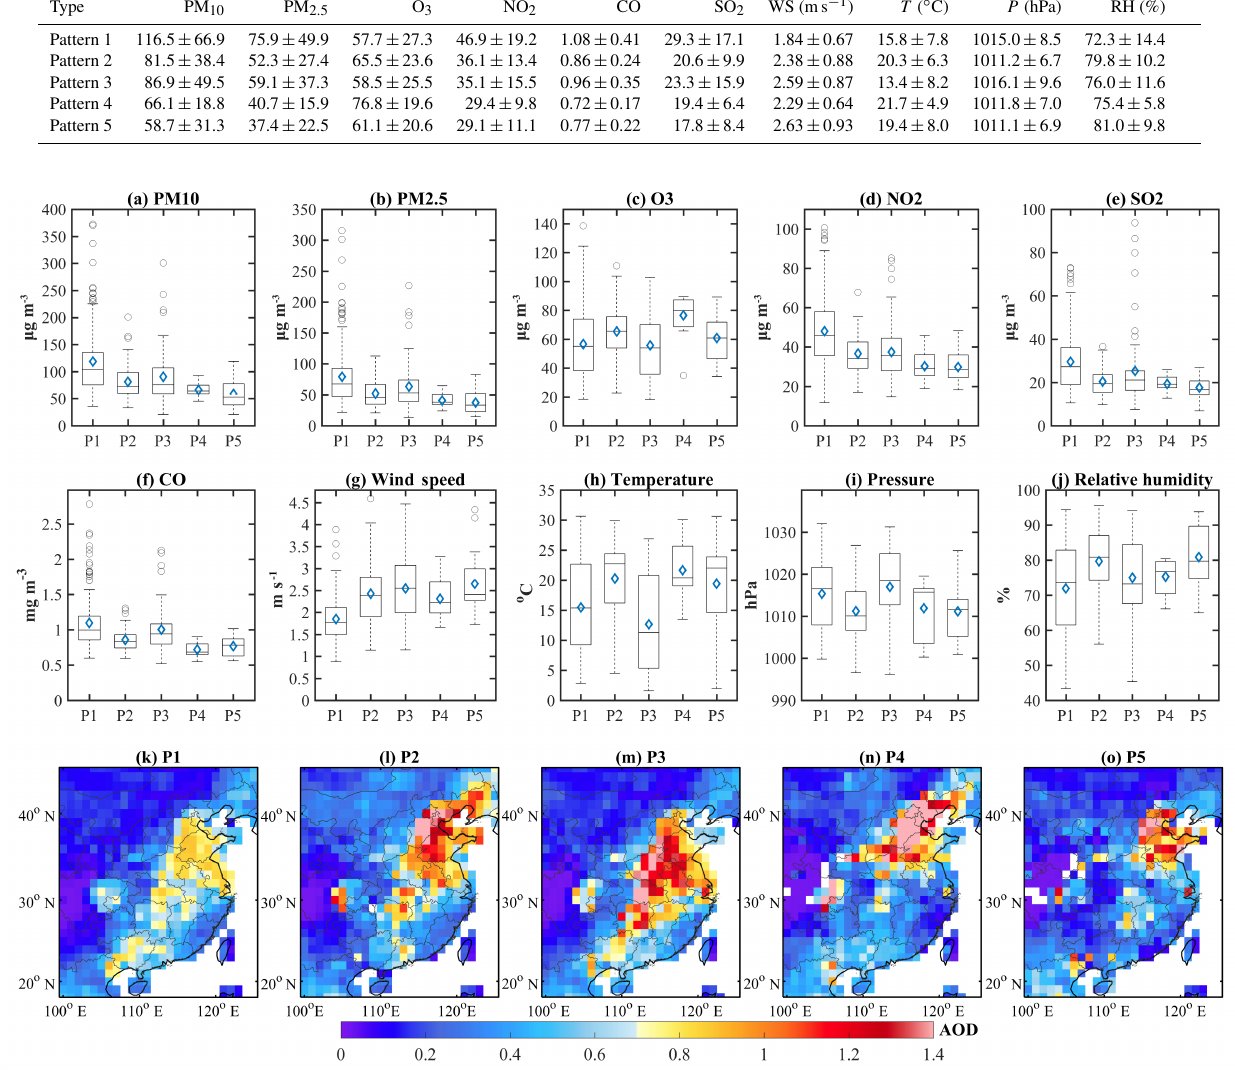
Figure 6. (a–j) Box-and-whisker plots for the mean values of air pollutant concentrations and meteorological parameters of 16 typical YRD cities. The edges of each box in (a–j) are the 25th and 75th percentiles, the band inside the box is the median, the diamond is the average, and the whiskers extend to the most extreme data values. (k–p) Spatial distributions of AOD for the five synoptic weather patterns. P1, P2, P3, P4, and P5 represent Pattern 1, Pattern 2, Pattern 3, Pattern 4, and Pattern 5,